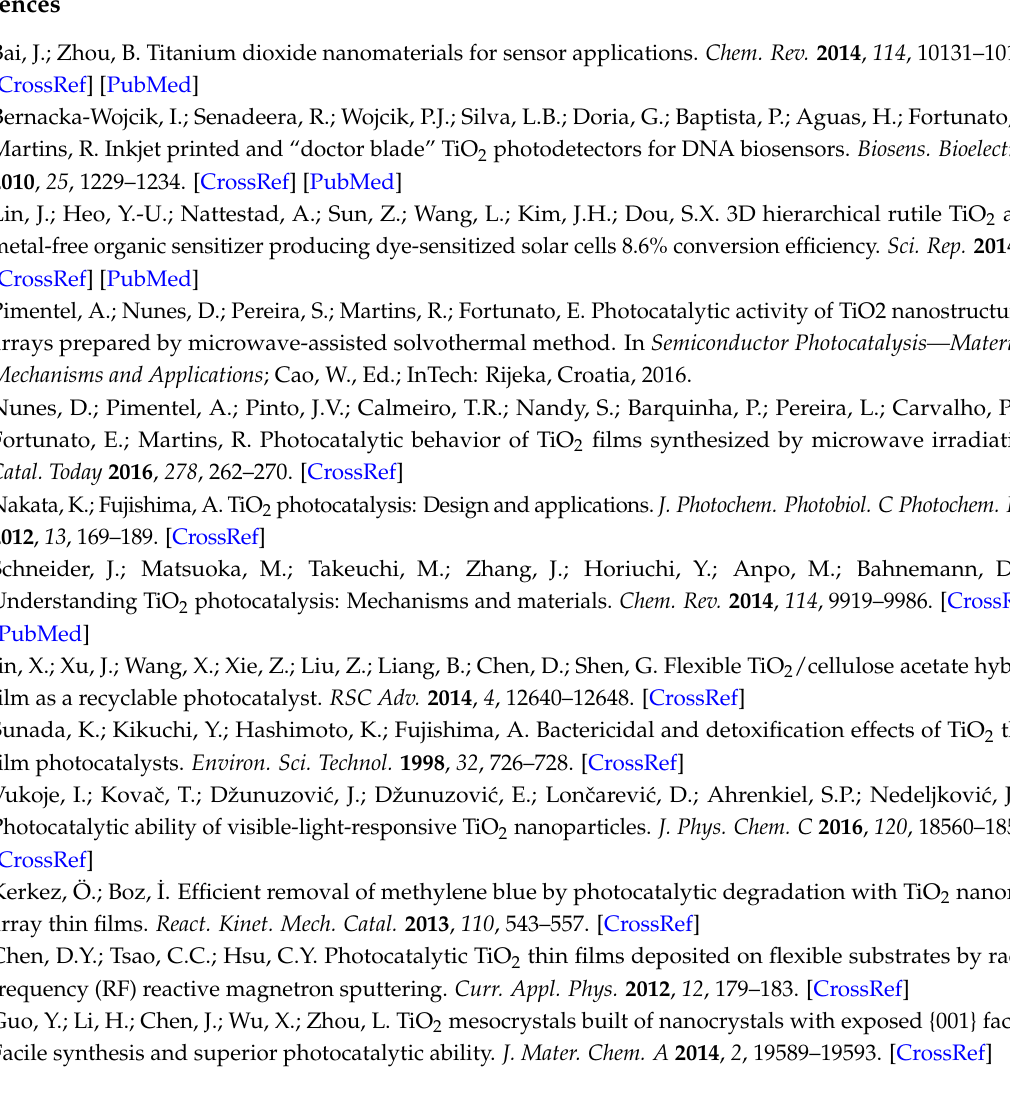
Figure S1: SEM images of the 80 ◦ C H 2 O nanorod spheres showing the nanorods radially arranged. The inset evidences the nanorod structures inside the sphere. Figure S2: Cross-section SEM images (artificial colored) of the: (a) 80 ◦ C H 2 O; and (e) 80 ◦ C EtOH nanorod arrays grown on ZnO seeded PET substrates, together with the corresponding X-ray maps of Ti: (b,f); O (c,g); and C (d,h). Figure S3: Rhodamine B absorbance spectra at different UV exposure times for the TiO 2 nanorod spheres produced with water at: (a) 80 ◦ C; and (b) 200 ◦ C; and with ethanol at: (d) 80 ◦ C; and (e) 200 ◦ C. The TiO 2 nanorod arrays grown on PET were also tested as photocatalystis at 80 ◦ C for: (c) water; and (f) ethanol. The photograph illustrates the PET substrate with the TiO 2 nanorod arrays covering a tube containing the pollutant solution. The absorbance spectra have not been normalized. Figure S4: Rhodamine B degradation ratio ( C / C 0 ) vs. UV exposure time for the 80 ◦ C H 2 O nanorod spheres and Degussa P25. Figure S5: Absorbance measurements over time at 500 nm for all the TiO 2 nanorod spheres. Figure S6: Cross-section SEM image of the ZnO seed layer prior to microwave